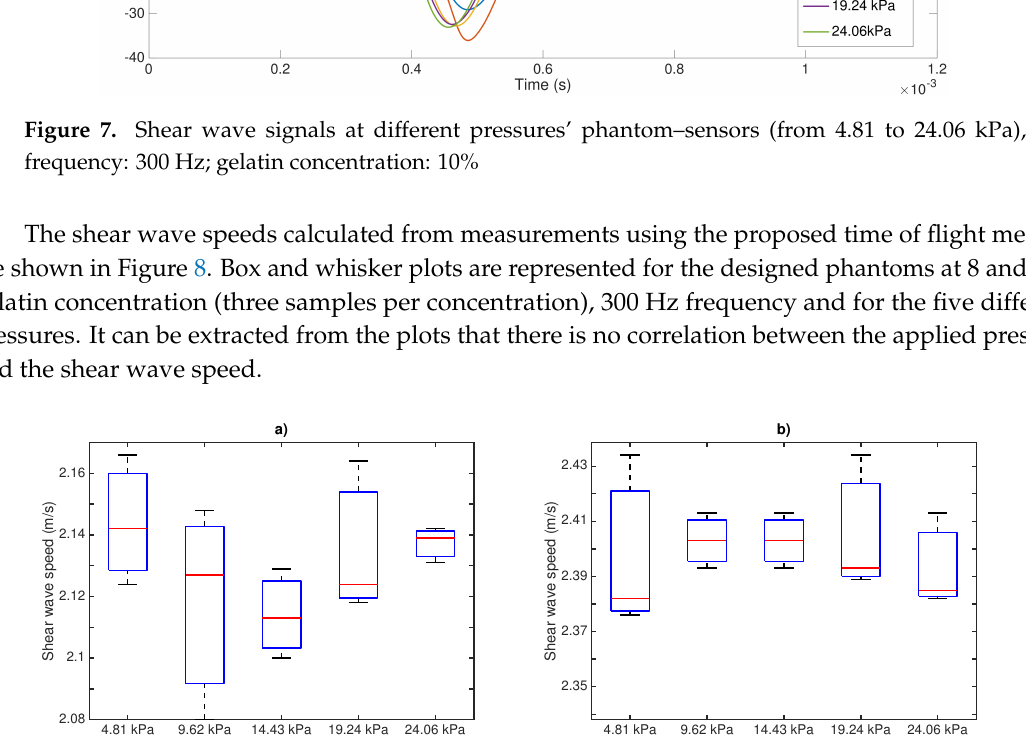
Figure 8. Box and whisker plots of shear wave speed measurements at different applied pressures phantom-sensor. Mean (lines within boxes), interquartile range (IQR, boxes) and extreme values (whiskers) are shown. ( a ) 8% gelatin; ( b ) 10%